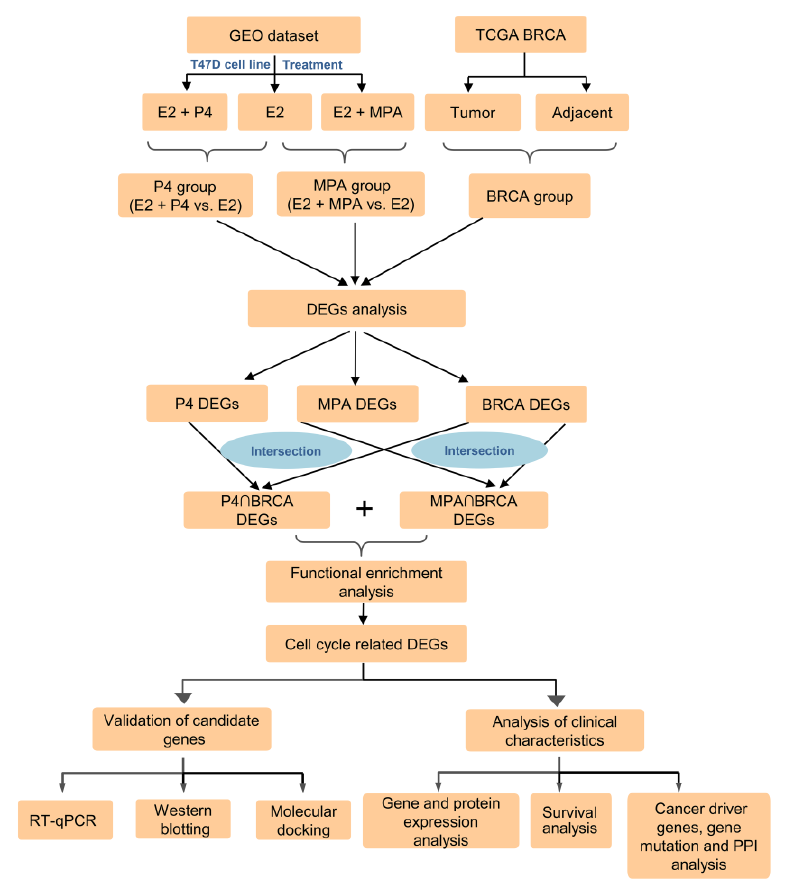
Figure 1. Schematic diagram of the methodology used in the study. GEO, the Gene Expression Omnibus; TCGA-BRCA, The Cancer Genome Atlas Breast Invasive Carcinoma database; E2, 17 β - estradiol; P4, progesterone; MPA, medroxyprogesterone acetate; DEGs, differently expressed genes; RT-qPCR, reverse transcription, and quantitative real-time polymerase chain reaction.